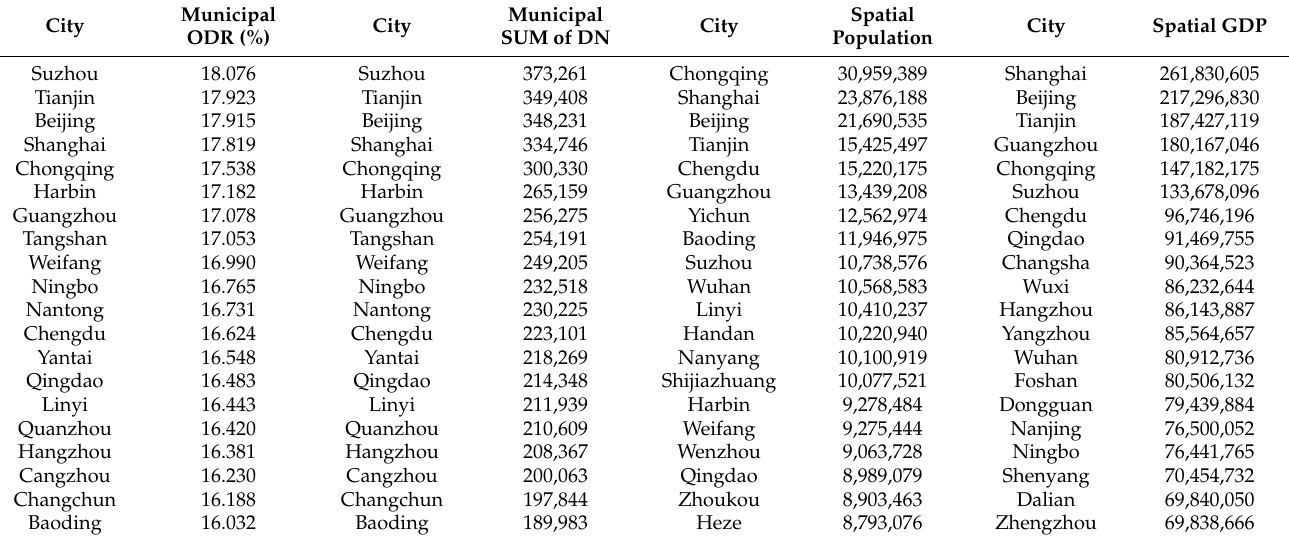
Table 7. Distribution of the municipal ODR and municipal SUM of DN, spatial population, and spatial